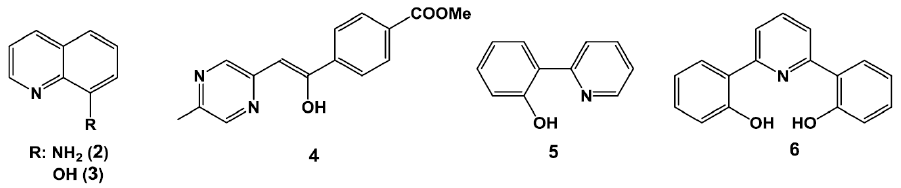
Figure 2. Complex formation using the previously reported fluorescent boron sensor DAHMI ( 1 ).